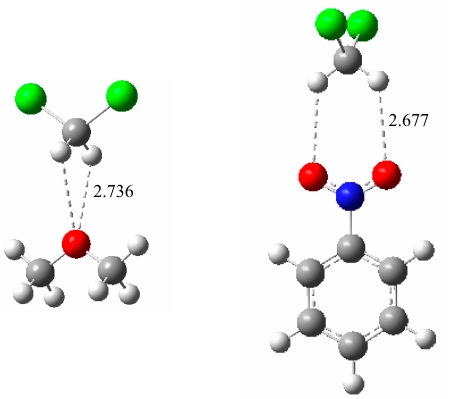
Figure 3. Stable structures for the solvation complexes between dimethyl ether and nitrobenzene with DCM stabilized by two H-bonds. None of them are local minima of the potential energy surface, but rather saddle points with two imaginary frequencies. Hydrogen bond distances in Å.